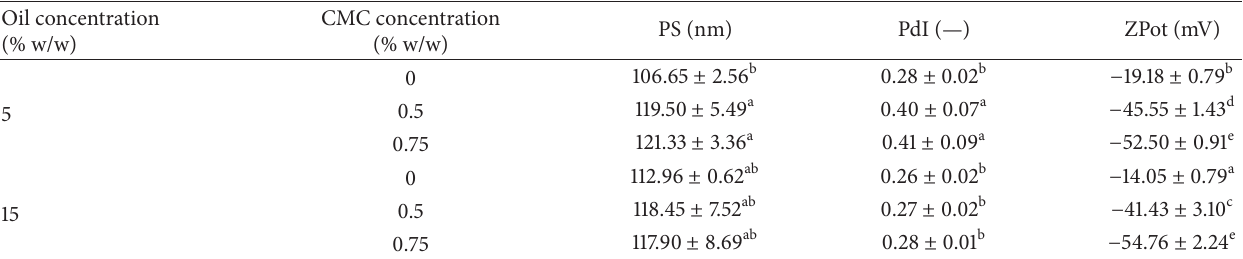
Table 2: Mean values and significant differences of particle size (PS), polydispersity index (PdI), and zeta potential (ZPot) for O/W nanoemulsions based on olive oil with different CMC